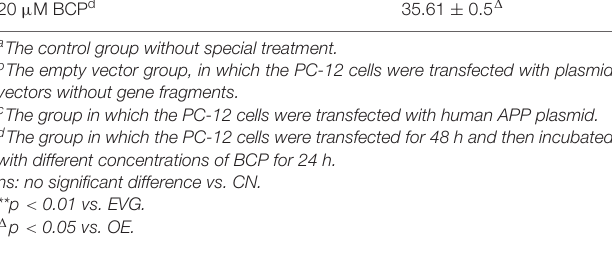
Frontiers in Aging Neuroscience |